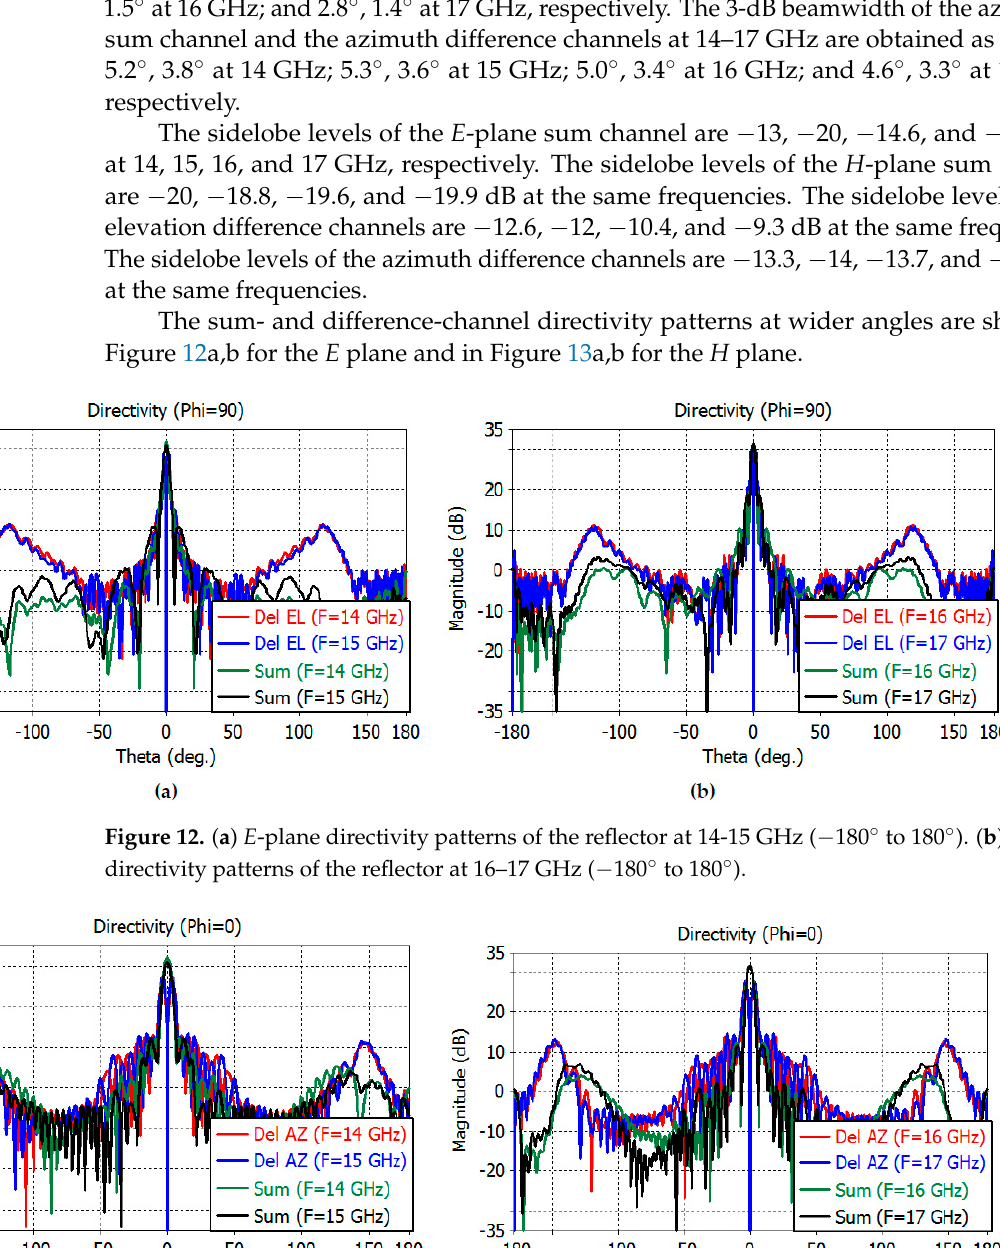
Figure 13. ( a ) H -plane directivity patterns of the reflector at 14-15 GHz (–180° to 180°). ( b ) H -plane directivity patterns of the reflector at 16-17 GHz (–180° to 180°).